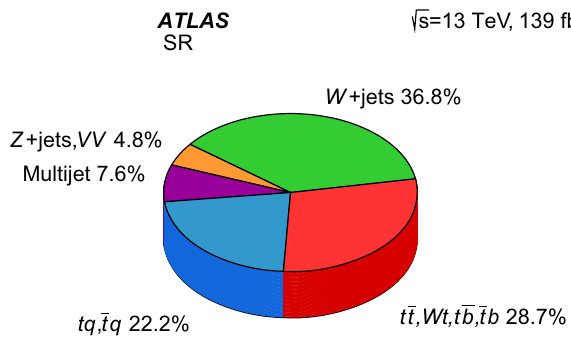
Fig. 3 Pie chart of the background composition of the SR. The SR comprises the two electron channels (barrel and endcap) and the muon channel. The pre-fit event yields are reported in Table 3